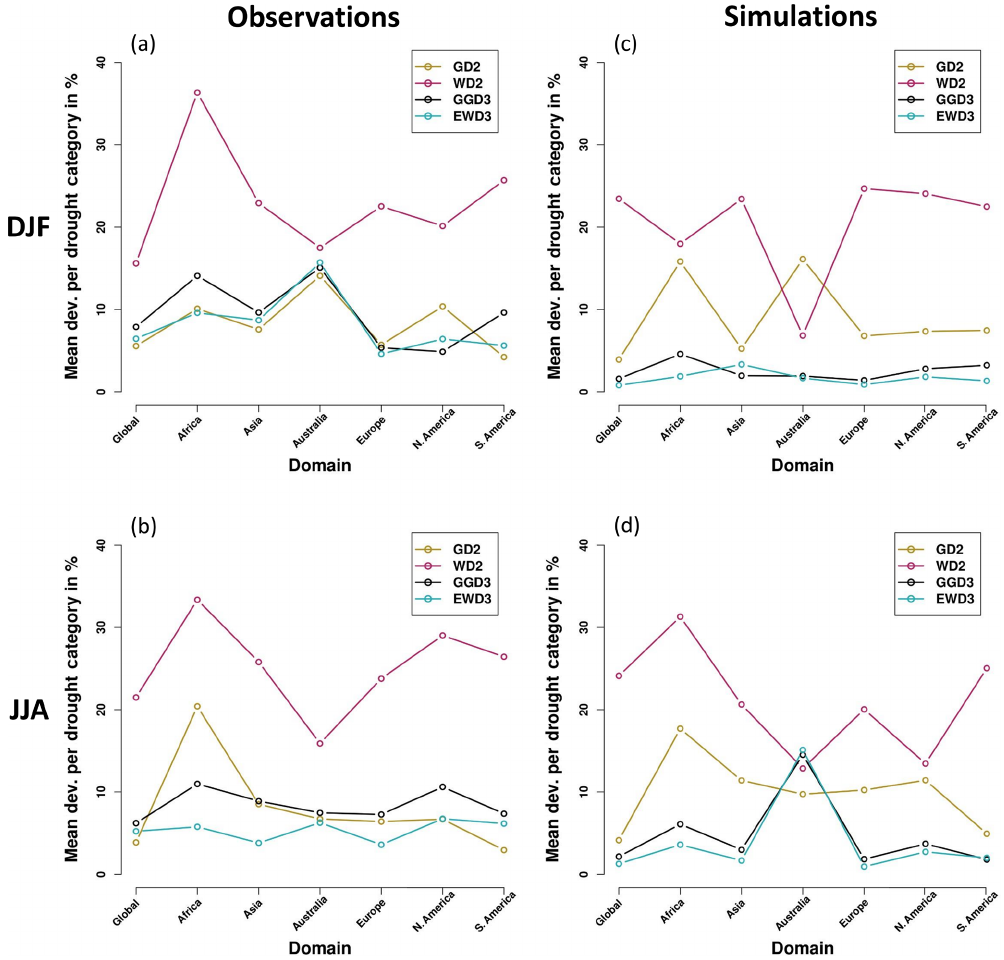
Figure 6. Mean deviations from N 0 , 1 per SPI category for the entire global land area and each investigated region. Results are depicted for observations (a, b) and simulations (c, d) during DJF (a, c) and JJA (b, d)